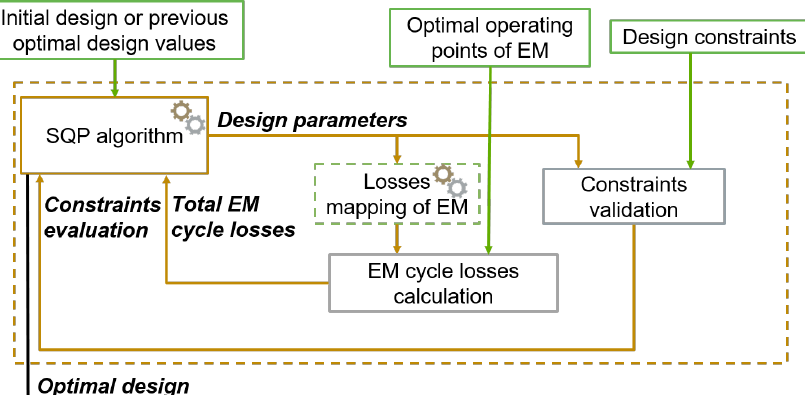
Figure 9. Design optimization block of IT + MR